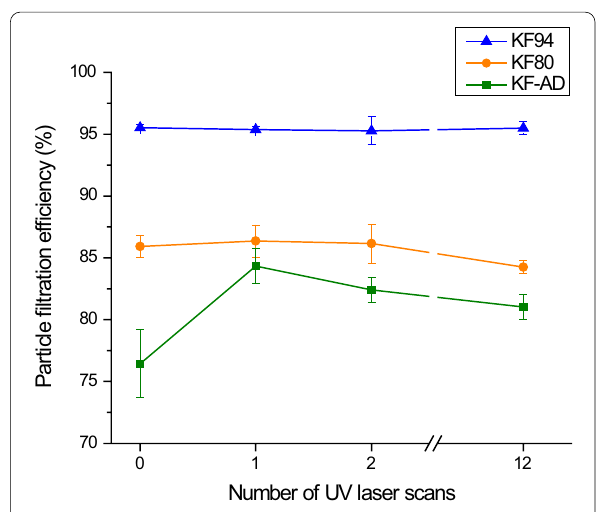
Fig. 5 Particle filtration efficiency of KF‑AD, KF80, and KF94 masks before and after 1, 2, and 12 UV laser